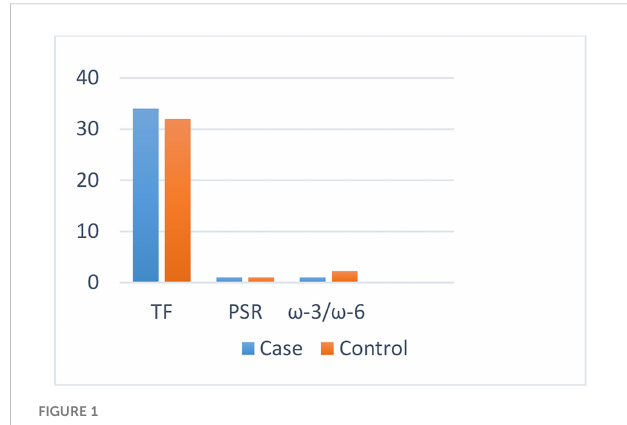
FIGURE 1 Dietary fat quality indices of the study population.